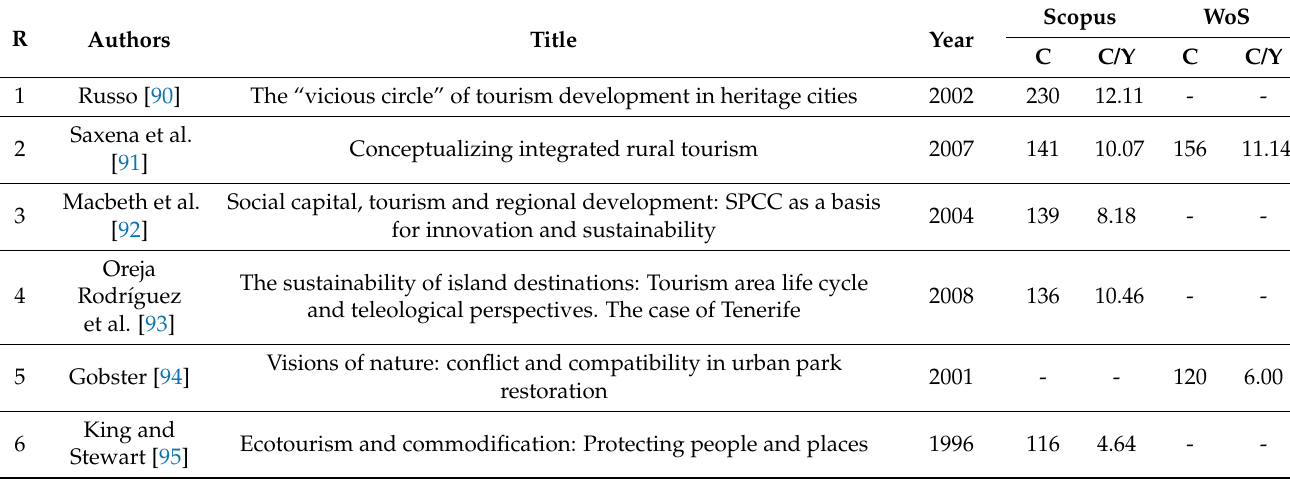
Table 5. Ranking of the most cited articles.